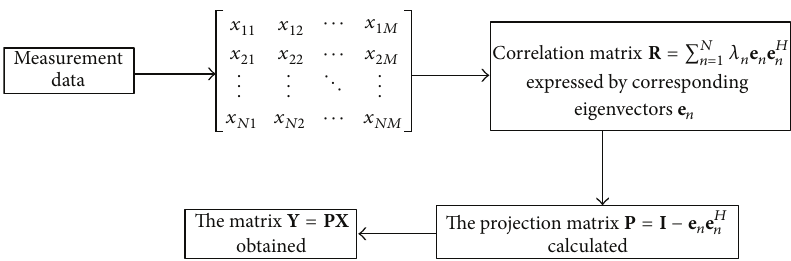
Figure 1: Schematic diagram of the projection matrix method.